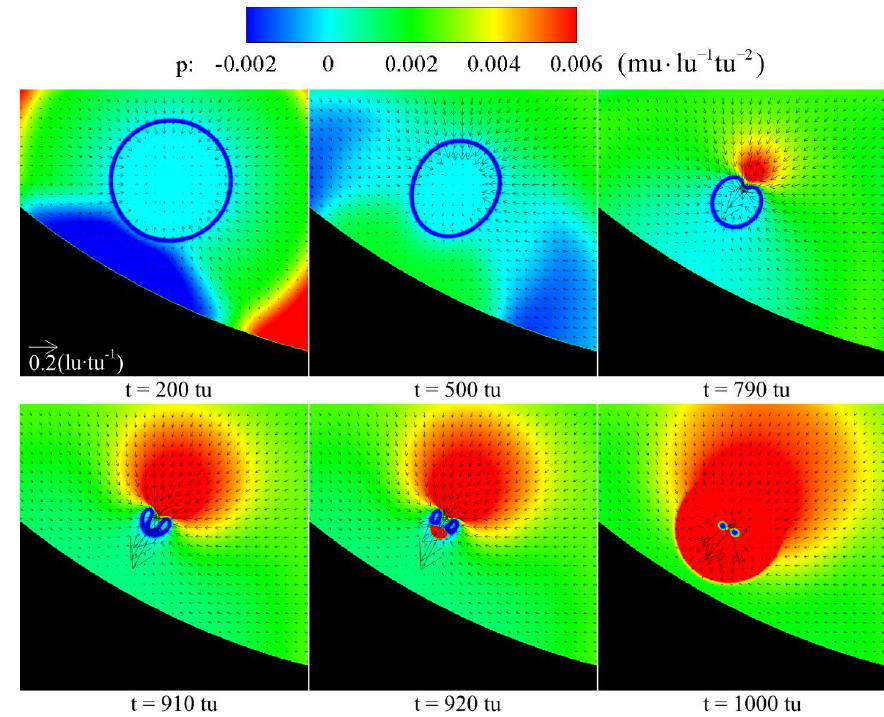
Figure 10. Pressure field and velocity field of cavitation-bubble collapse for Case 5.